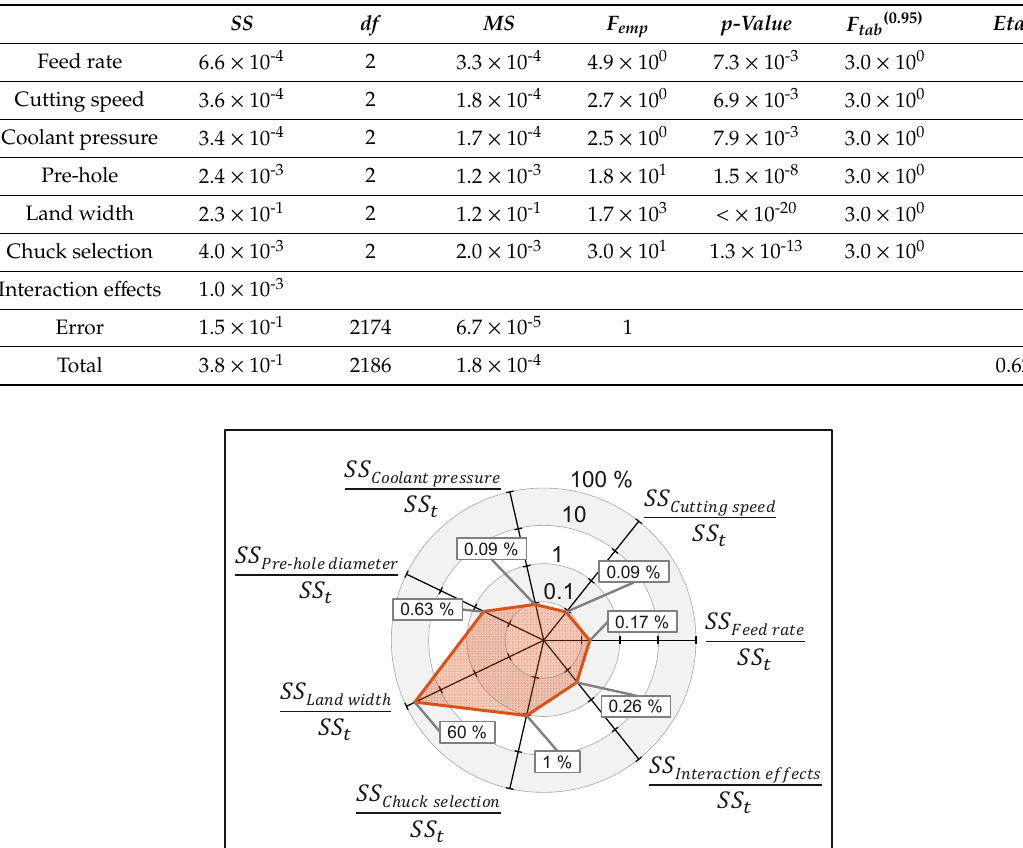
Table 2. ANOVA-Table.